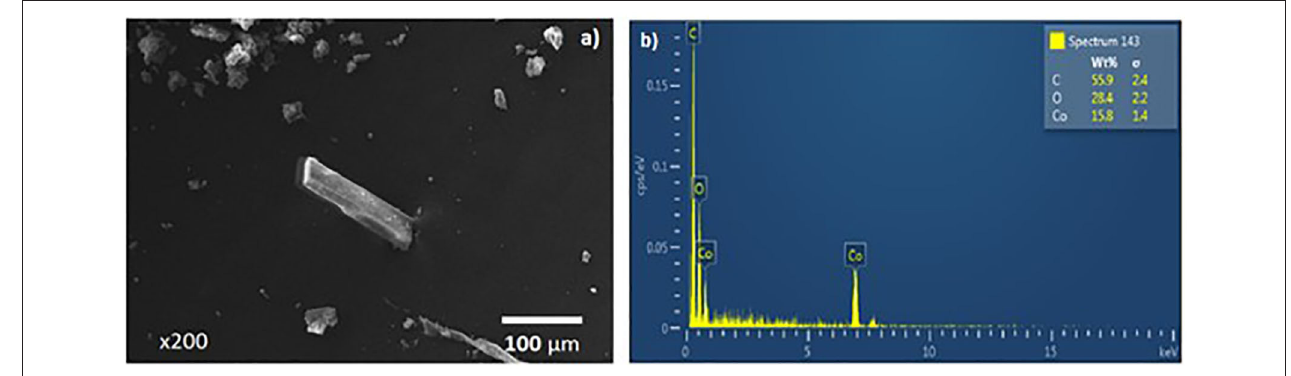
FIGURE 3 | MOF micrograph (a) and dispersed electron spectrum (b) .